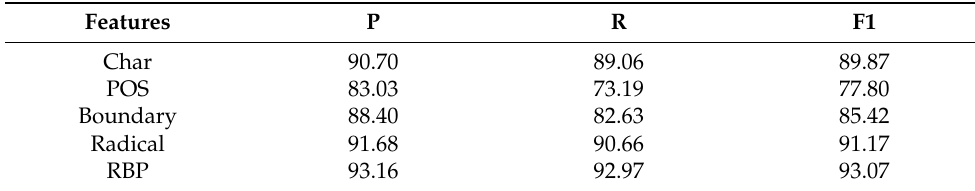
Table 4. Model multi-feature embedding results.